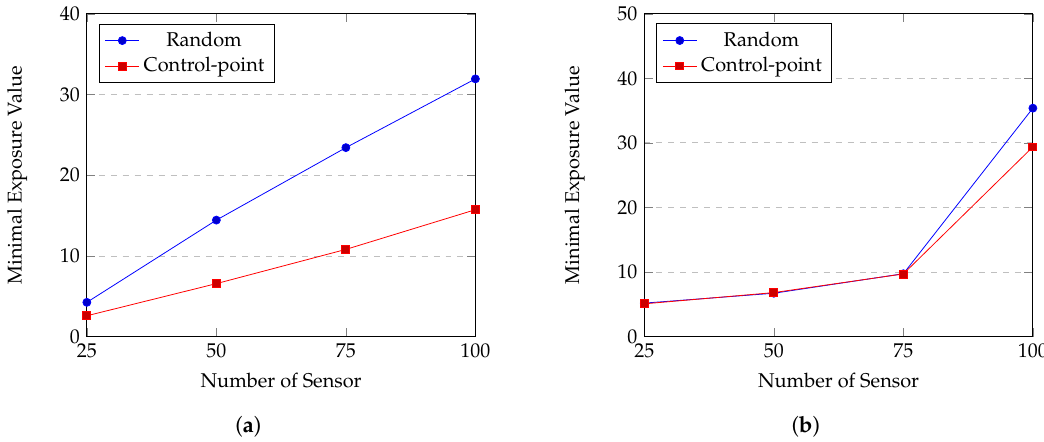
Figure 11. Random vs. control-point initialization: ( a ) Gauss distribution. ( b ) Uniform